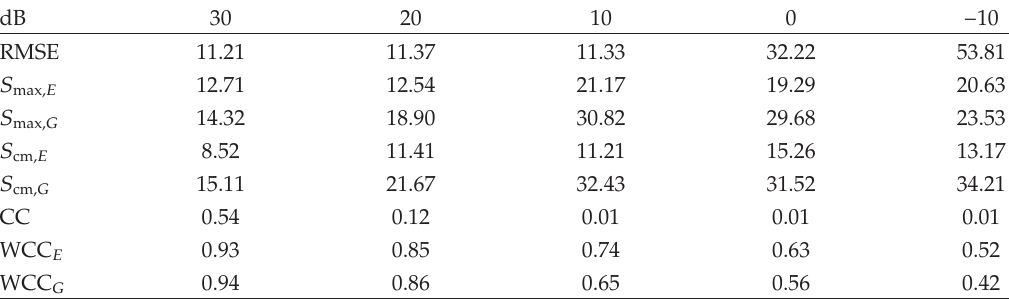
Table 4: Evaluation of reconstructions with 2,000 randomly selected source